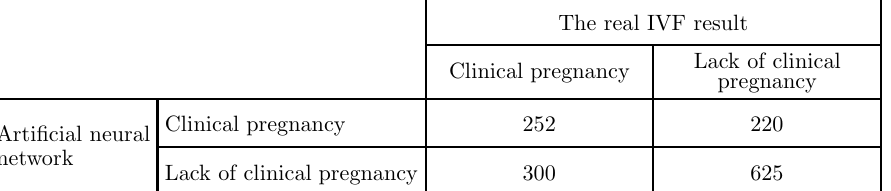
Table 8. The predictive effectiveness of the created neural network model (after